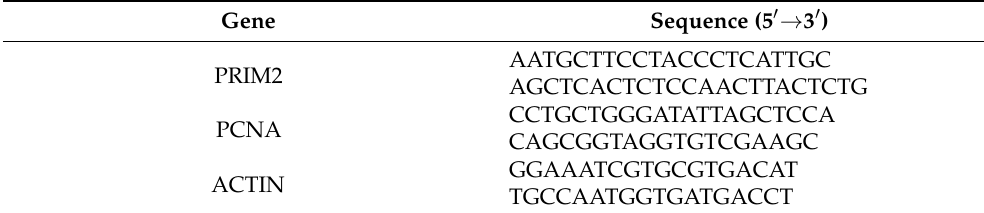
Table 1. The sequence of primers for Real-time PCR.